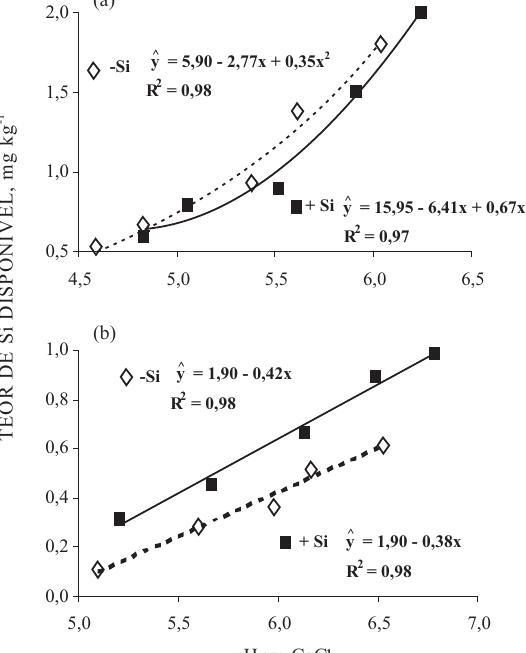
Figura 6. Acúmulo de Si na parte aérea (folha + caule) do arroz e leitura SPAD, em função de diferentes relações N-NH 4+ :N-NO 3- .